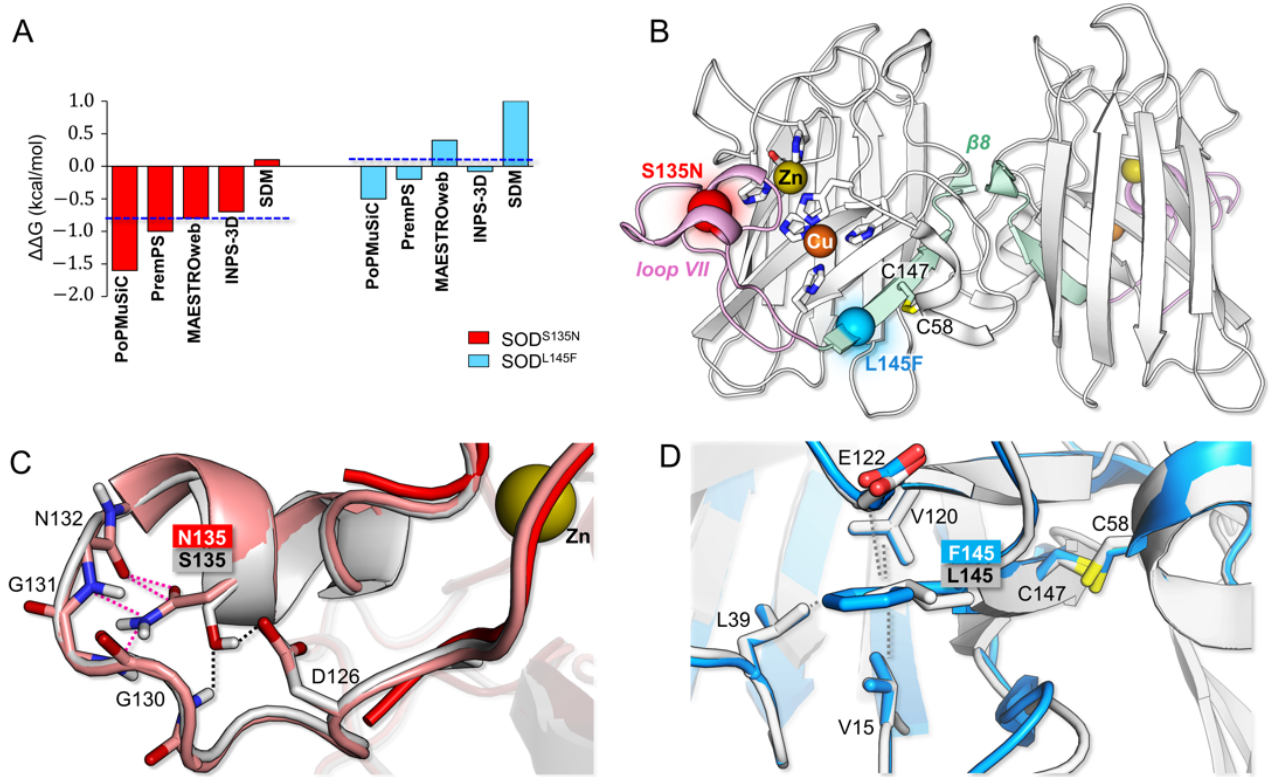
Figure 1. Structural properties of p.S135N and p.L145F mutants. ( A ) Theoretical protein stability changes upon mutation (expressed as folding free energy variation ∆∆ G = ∆ G (wild type) − ∆ G (mutant), in kcal/mol). For each mutation, the average ∆∆ G resulting from the five tested methods is indicated by a horizontal blue–dashed line. ( B ) Cartoon representation of SOD1 homodimeric structure (2C9V). S135N and L145F positions are indicated by a red and a light blue sphere, respectively (in the single monomeric unit). Loop VII (electrostatic loop) is highlighted in pink, while the β 8 sheet is in pale green. Side-chains of selected residues have been represented as sticks: C58, C147 and Cu and Zn first coordination sphere. ( C ) Superimposition of wild-type crystal structure (2C9V, in grey), p.S135N in silico model (in salmon), and crystal structure (1OZU, in red), with a focus on the electrostatic loop portion 123–142. In 1OZU, part of the latter is absent. H-bonds of S135 with D126 and G130 are reported as black–dotted lines. Steric clashes with residues 130–132, originating from S135 substitution by N in the in silico model, are reported as pink–dotted lines. ( D ) Superimposition of wild-type crystal structure (2C9V, in grey) and p.L145F in silico model (in light blue), with focus on site 145 in β 8. Hydrophobic contacts of both L (in the wild type) and F (in the mutant) are indicated as grey–dotted lines. The proximal disulphide bond has been used as evidence. Atom coloring: O = red; N = blue; S = yellow; H = white; C = grey, pale green, salmon or light blue, according to the color of the corresponding secondary structure element.